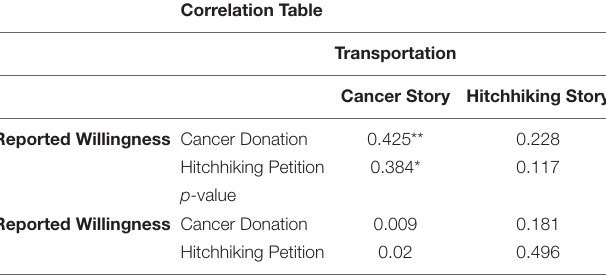
TABLE 2 | Correlations between narrative transportation and pro-social